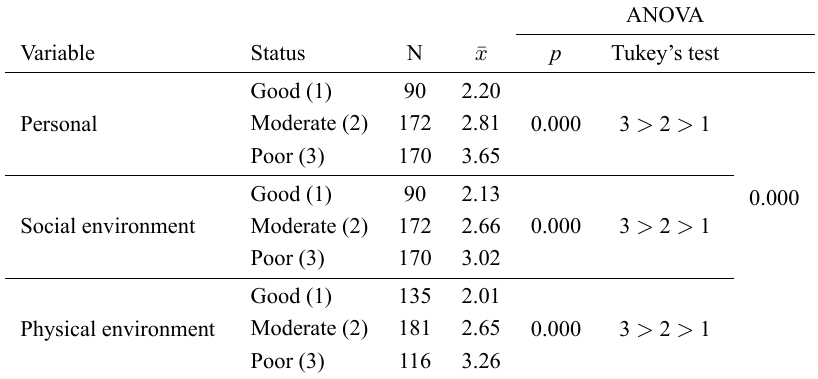
Table 6. ANOVA test results for subdimensions of barriers to physical activity, by participants’ self-perceived health status after the COVID-19